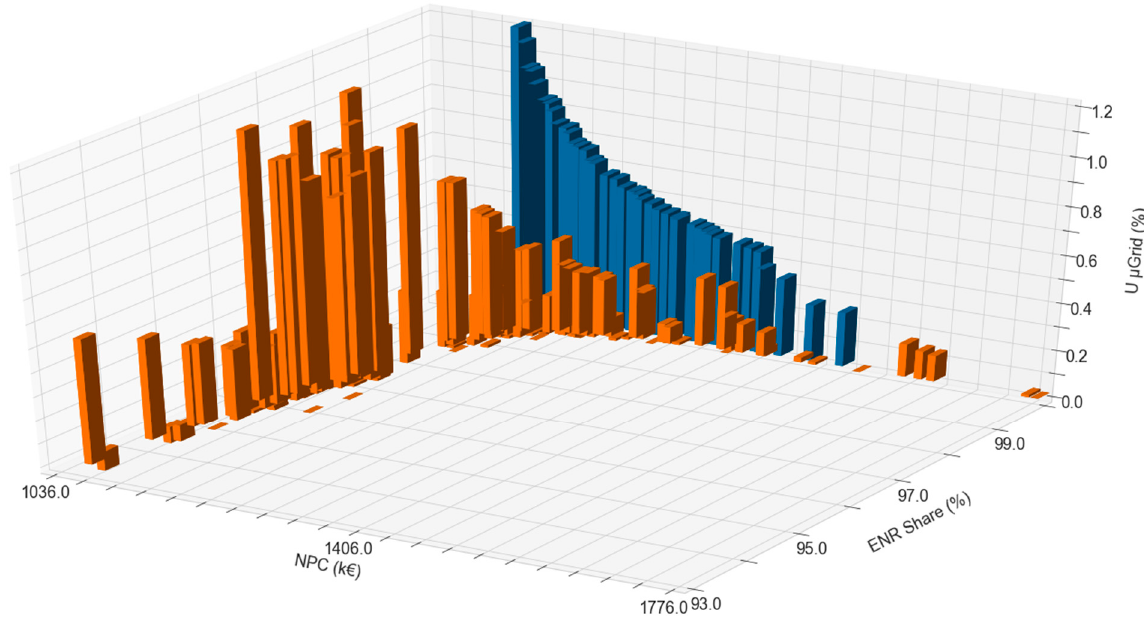
Figure 7. 3D Pareto surface of non-dominated solutions (in orange: solutions with gensets, in blue: solutions with no gensets).